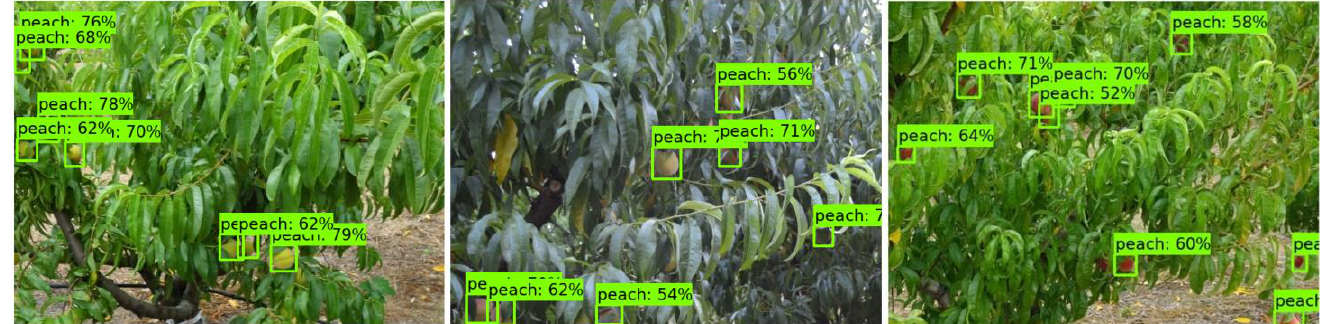
Figure 16. Detection sample for the Catherine peach cultivar ( left ), Sweet Dream peach cultivar ( middle ), and Royal Time peach cultivar ( right ), (adapted from [52]).